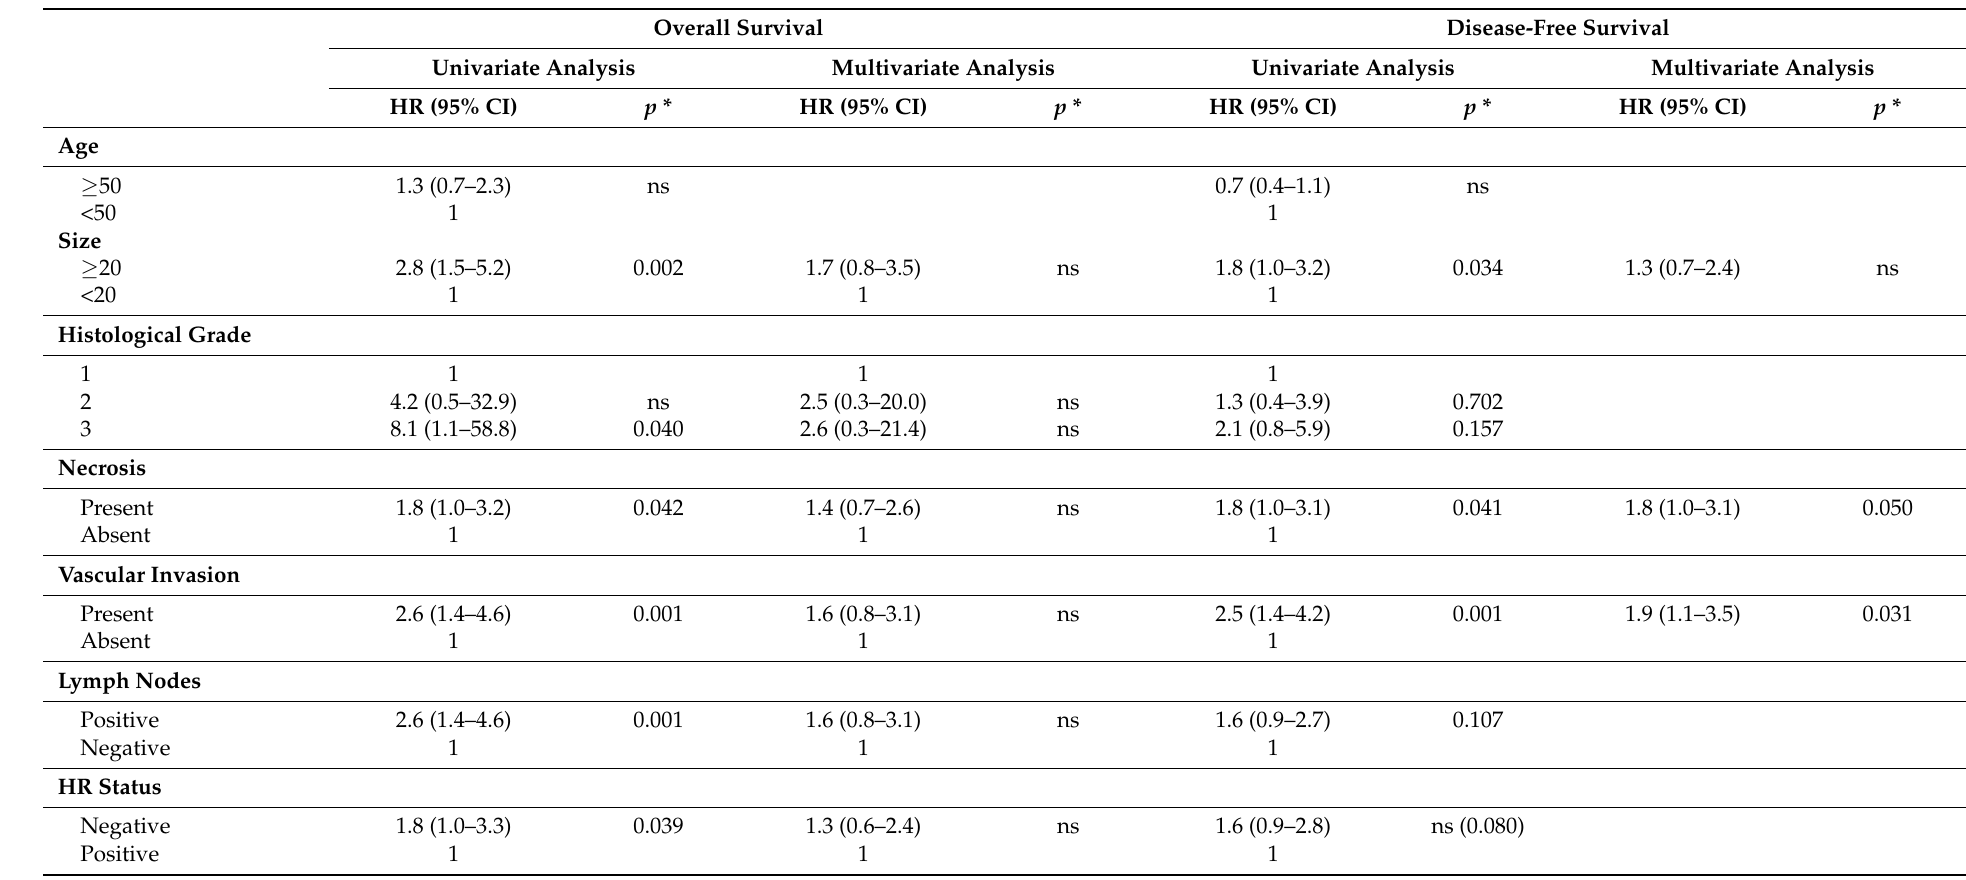
Table 2. Univariate and multivariate analysis of OS and DFS for all variables included in the study. Overall Survival Disease-Free Survival Univariate Analysis Multivariate